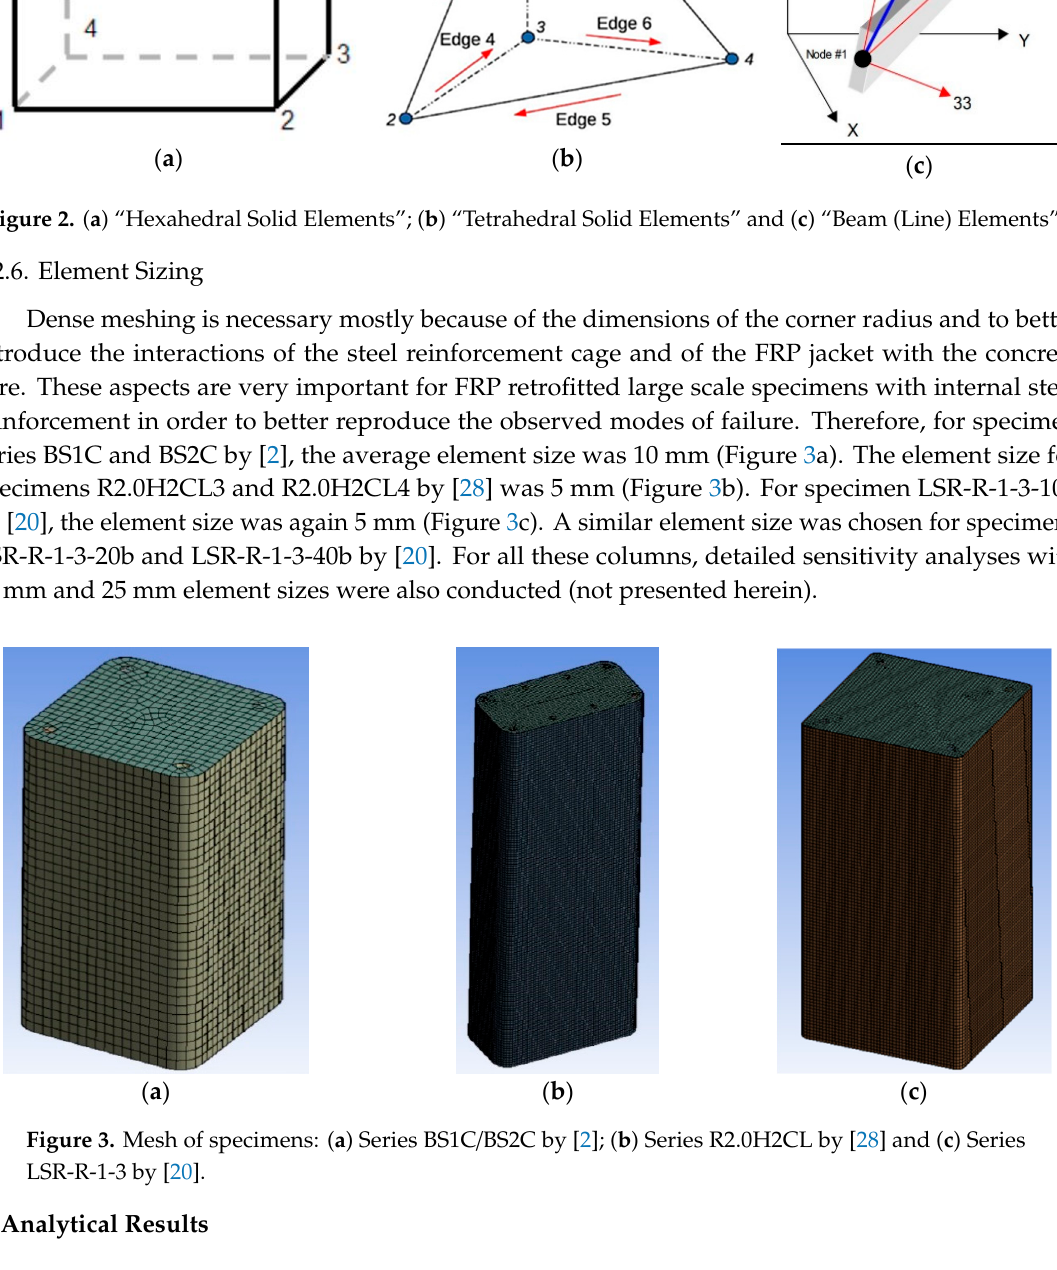
Figure 3. Mesh of specimens: ( a ) Series BS1C/BS2C by [2]; ( b ) Series R2.0H2CL by [28] and ( c ) Series LSR-R-1-3 by [20].